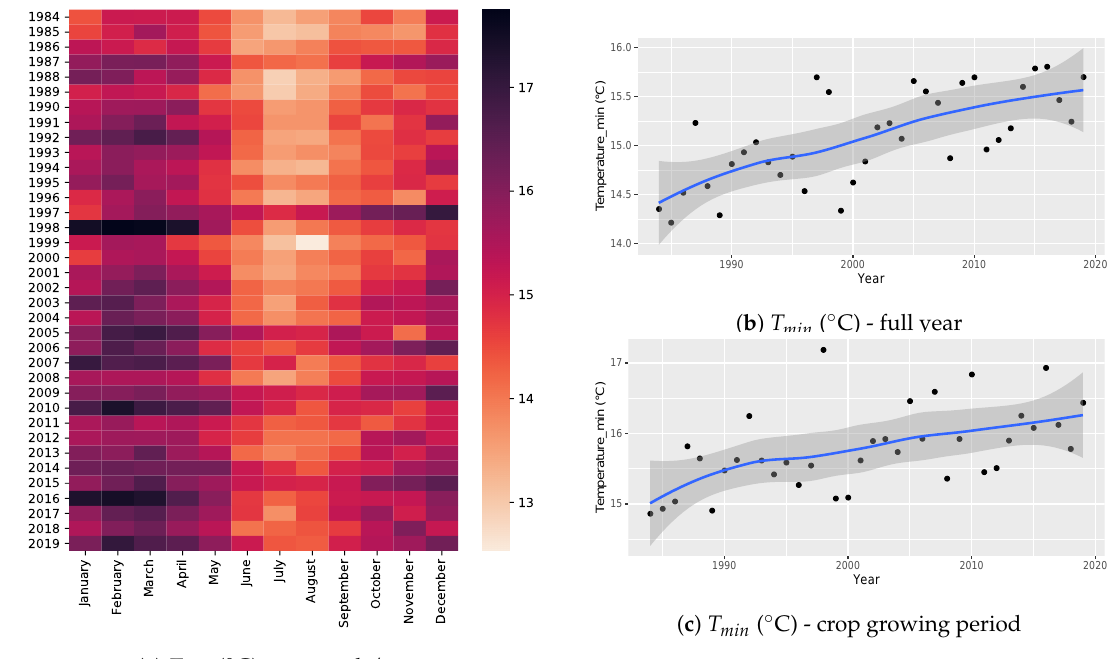
Figure A10. Time series of average minimum temperature ( ◦ C) in Loja from 1984 to 2019. ( a ) Heat-map of T min ( ◦ C) per each month and year. The color scale represents the temperature in ◦ C. ( b ) T min ( ◦ C) averaged during the full year. ( c ) T min ( ◦ C) averaged during the maize crop growing period in Ecuador (January–May). Each dot represents one record, the blue line shows the smoothed time series and the shaded area represents the 95% confidence interval.